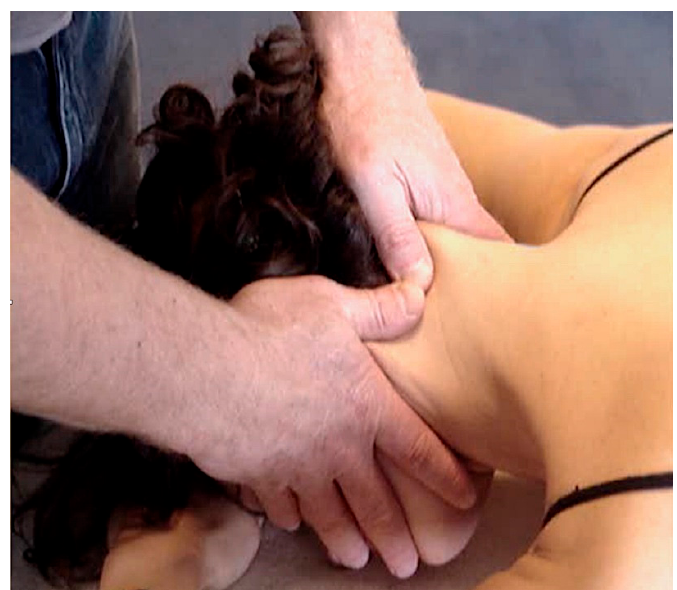
Figure 5. Unilateral posterior ‐ anterior mobilization of the upper cervical spine.